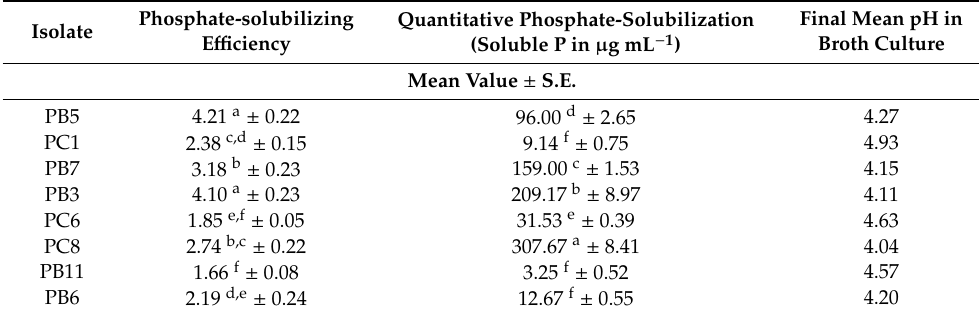
Table 3. Phosphate-solubilization e ffi ciency and quantitative phosphate-solubilization estimation based on soluble P by phosphate-solubilizing